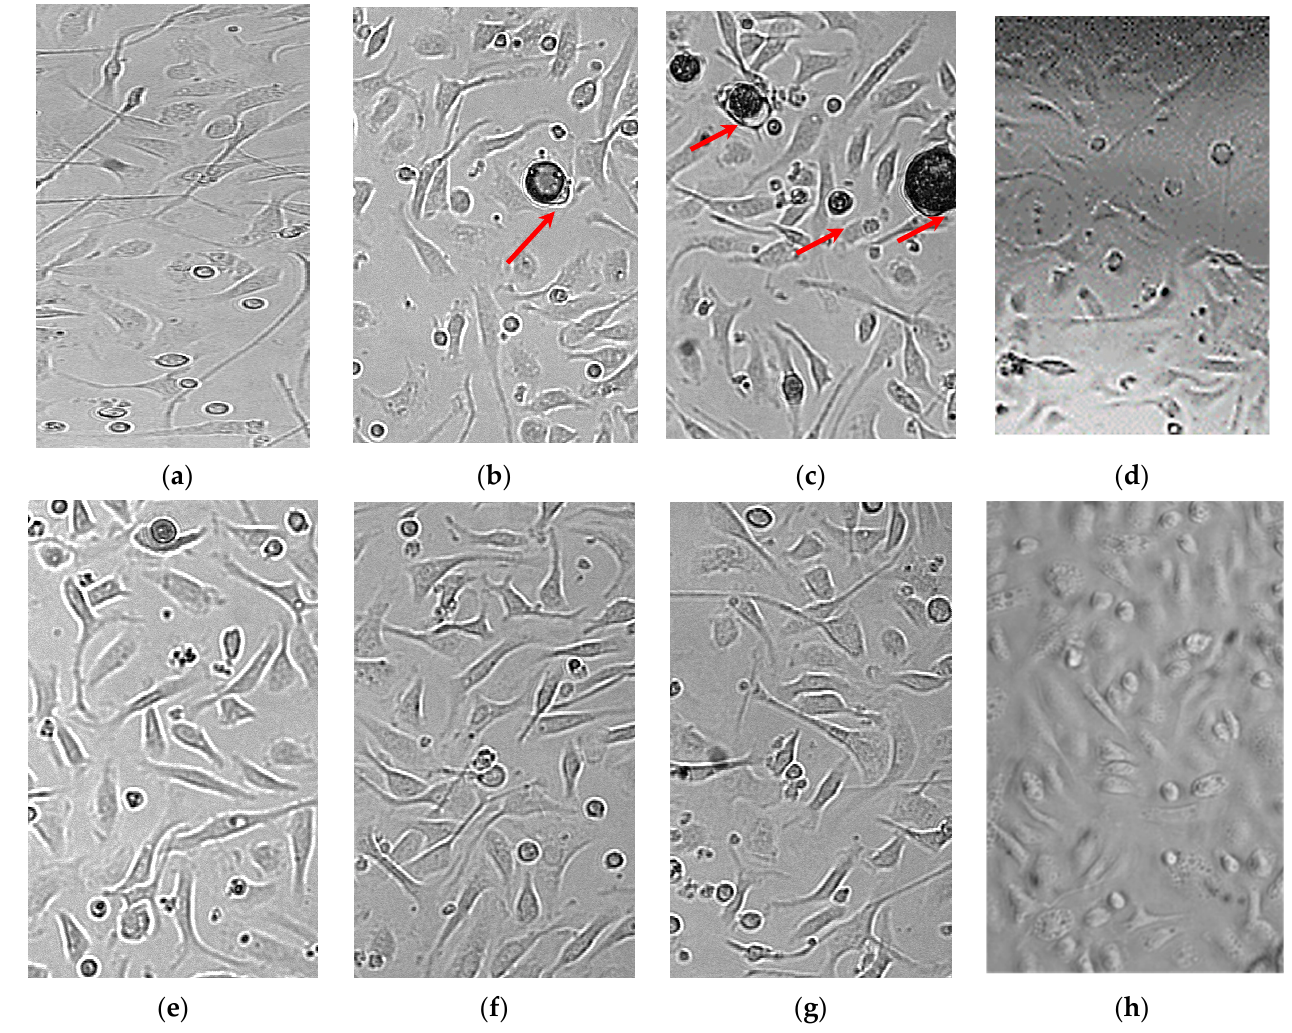
Figure 8. Optical images of intact murine peritoneal macrophage cultures incubated together with and without PLGA/LFX microparticles or scaffolds for 7 days. 200× magnification. The arrows in ( b , c ) indicate PLGA/LFX microparticles. ( a ) Spontaneous MPh lysis. ( b ) Microparticles 12.5/0. ( c ) Microparticles 200/0. ( d ) Scaffold 500 µ g. ( e ) Microparticles 1.25/0.125. ( f ) Microparticles 2.5/0.25. ( g ) Microparticles 5/0.5. ( h ) MPh infected with Mtb (30–40% lysis). Table 2. Growth of Mycobacterium tuberculosis H37Rv on the Dubos agar medium within 7 days of incubation in the presence of PLGA microparticles in vitro and ex vivo.